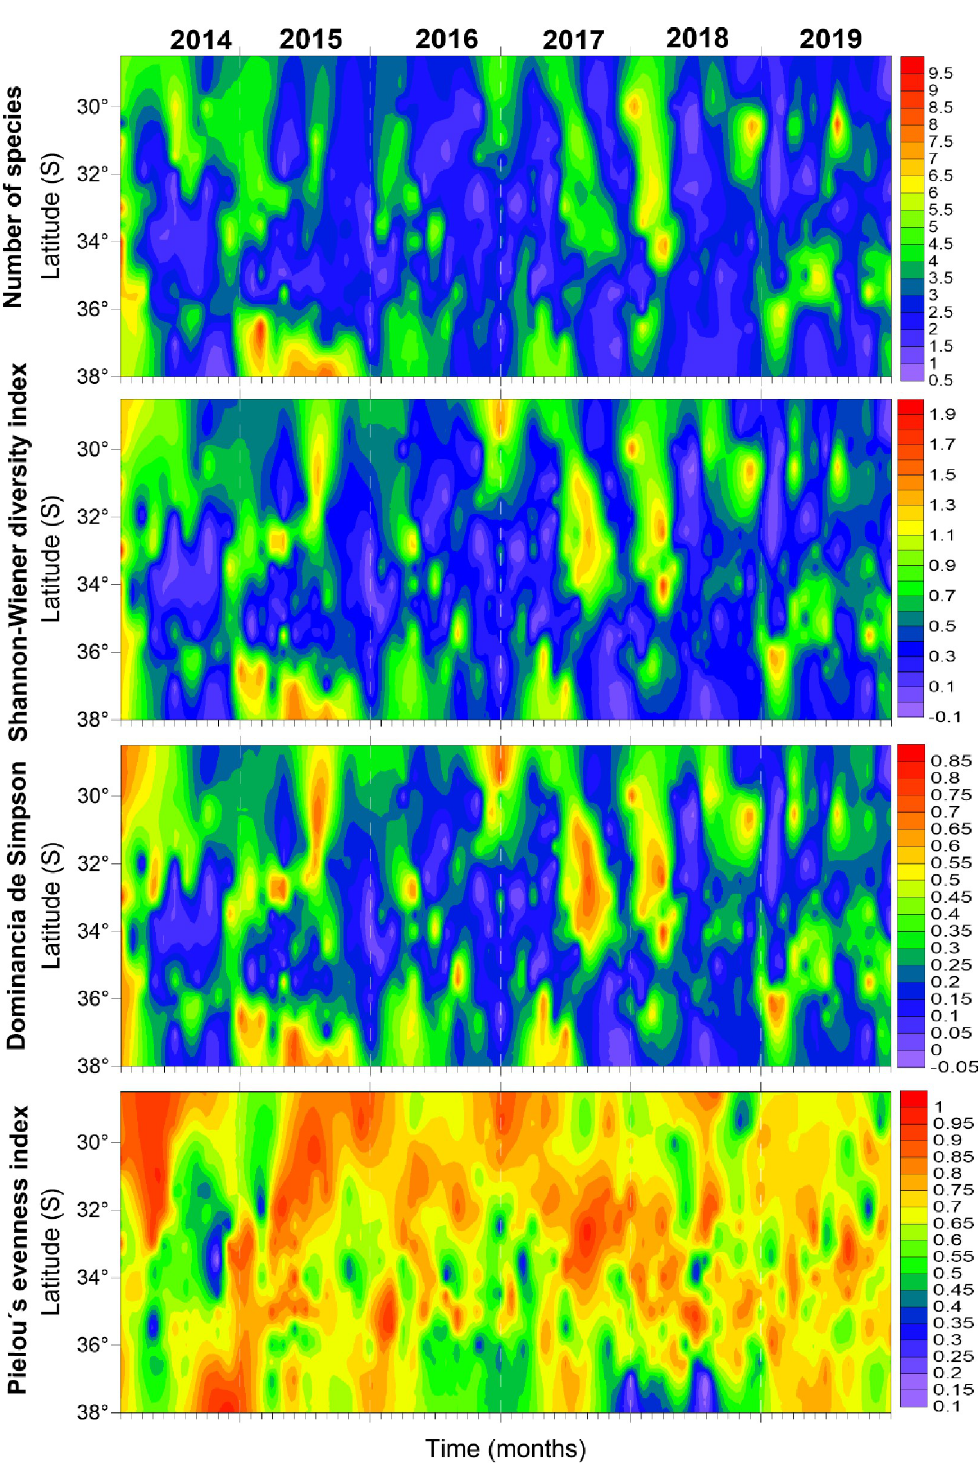
Fig 6. Hovmo ¨ ller diagram (latitude vs months between 2014–2019) of the alpha-diversity indices of the discarded faunal demersal community off central Chile.